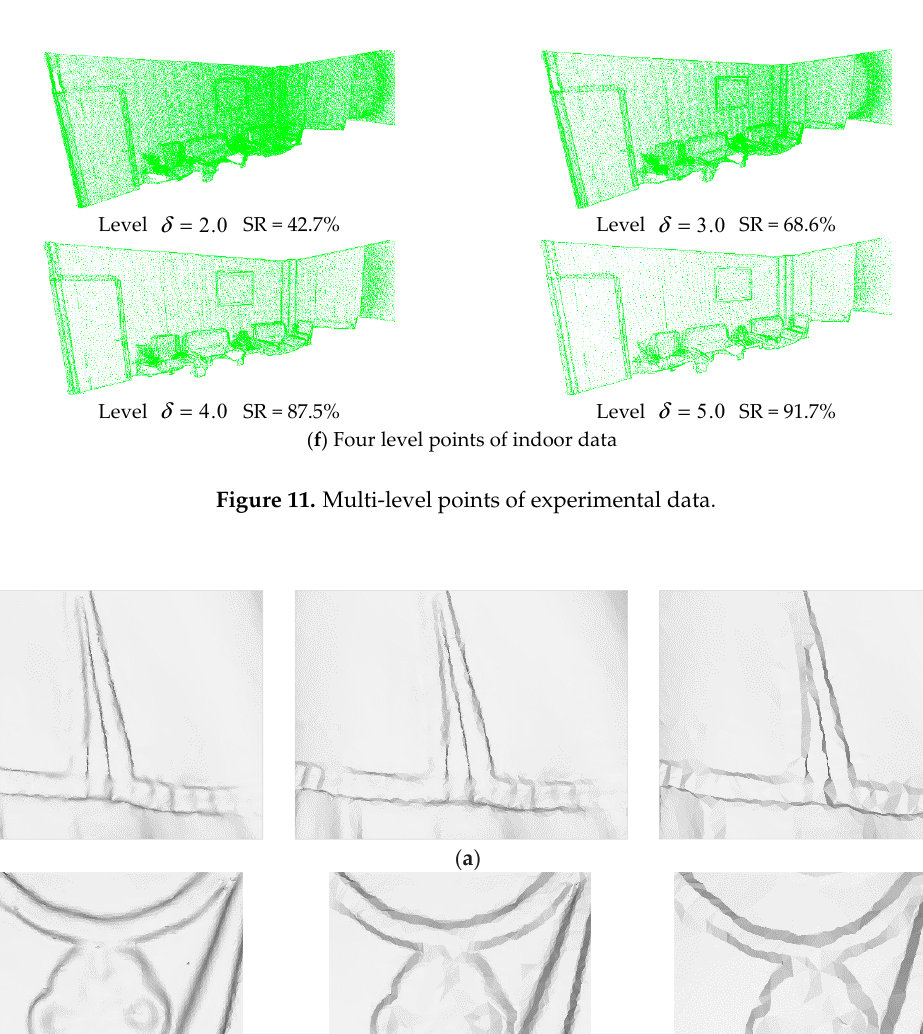
Figure 11. Multi-level points of experimental data.